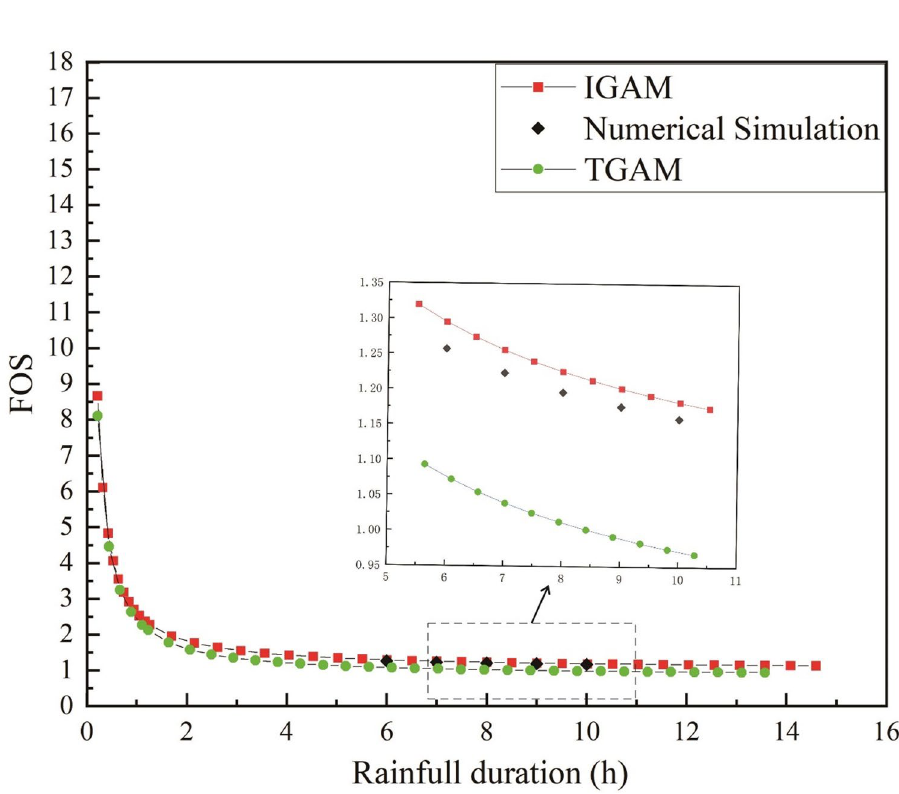
Figure 5. Variation of FOS of different models with rainfall